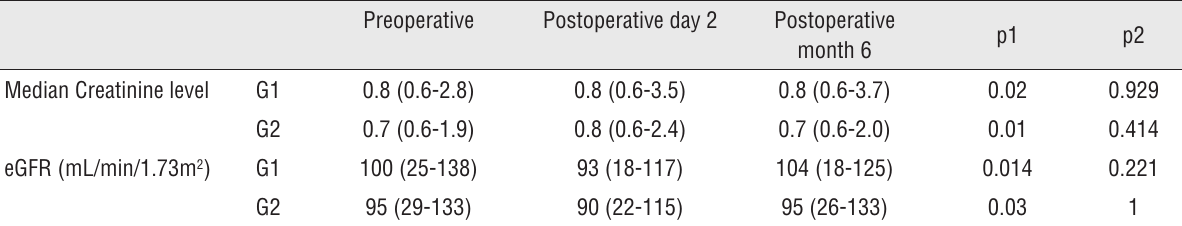
Table 3 - Renal function changes overtime between